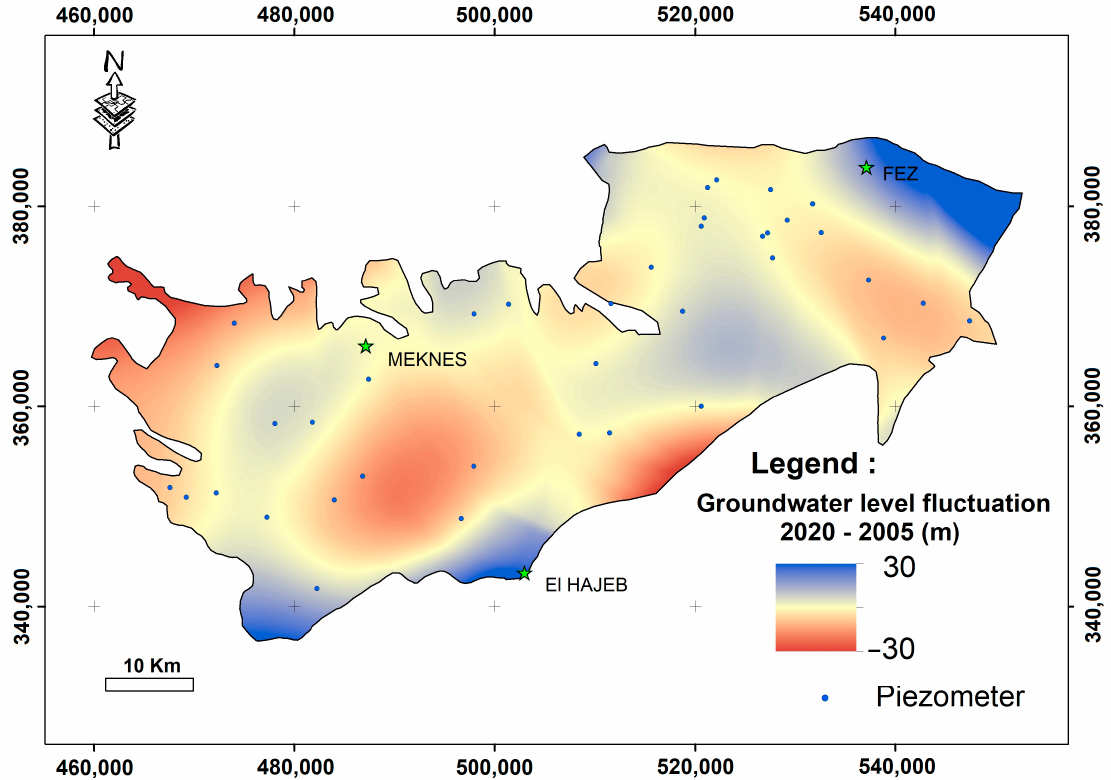
Figure 14 . Interpolated map of the groundwater level difference values between 2005 and 2020 . Figure 14. Interpolated map of the groundwater level difference values between 2005 and